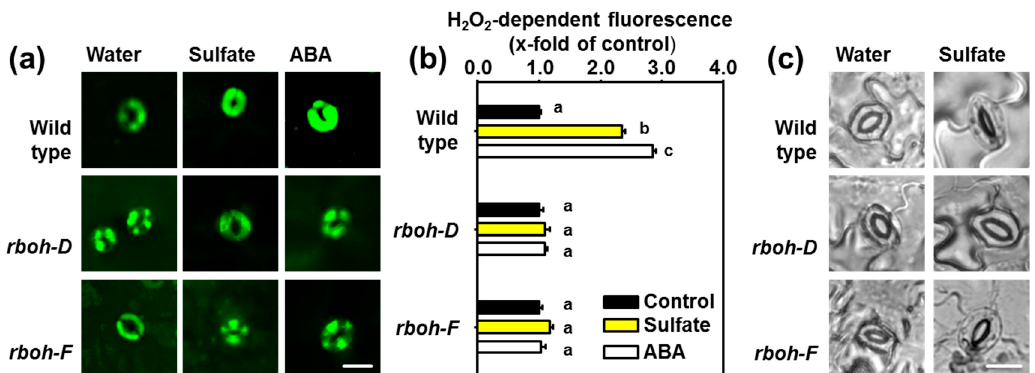
Figure 4. Sulfate-induced stomatal closure and ROS formation require the NADPH oxidases RBOHD, and RBOHF ( a ) Visualization of reactive oxygen species (ROS) with the H 2 O 2 -selective dye 2',7'- dichlorofluorescein (H2DCF) as described in material and methods. Epidermal peels of 5-weeks–old soil-grown wild-type, rboh-D , and rboh-F plants were floated on water at pH 5.5 or water supplemented with sulfate (15 mM MgSO 4 ) or ABA (50µM) for three hours prior staining of ROS. ( b ) Quantification of ROS staining in guard cells floated on water (control, black) supplemented with sulfate (15 mM, yellow) or ABA (50 µ M, white). Letters indicate statistically significant di ff erences between groups determined with the one Way ANOVA test ( p < 0.05, n = 50 stomata, derived from epidermal peels of five individual plants). Values represent means ± standard deviation (SD). ( c ) Representative guard cells embedded in epidermal peels of the wild-type and the rboh-D , and rboh-F mutants after treatment with water or water supplemented with sulfate (15 mM). Scale bar, 10 µm.